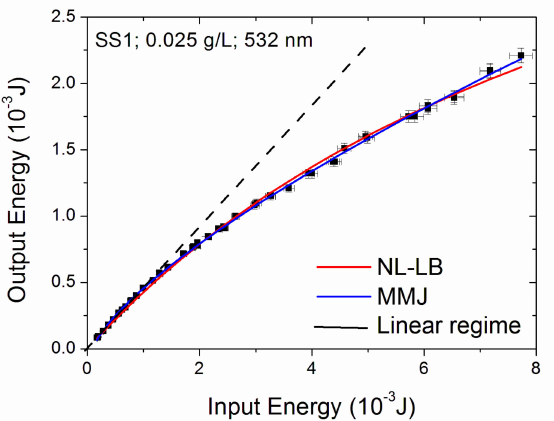
Figure 4. Fit of NL-LB and MMJ models on optical limiting curve of the lowest concentration sample at 532 nm laser wavelength. The dashed black line is only a visual reference for linearity. The experimental uncertainties on the measured energies is also shown in the plots.